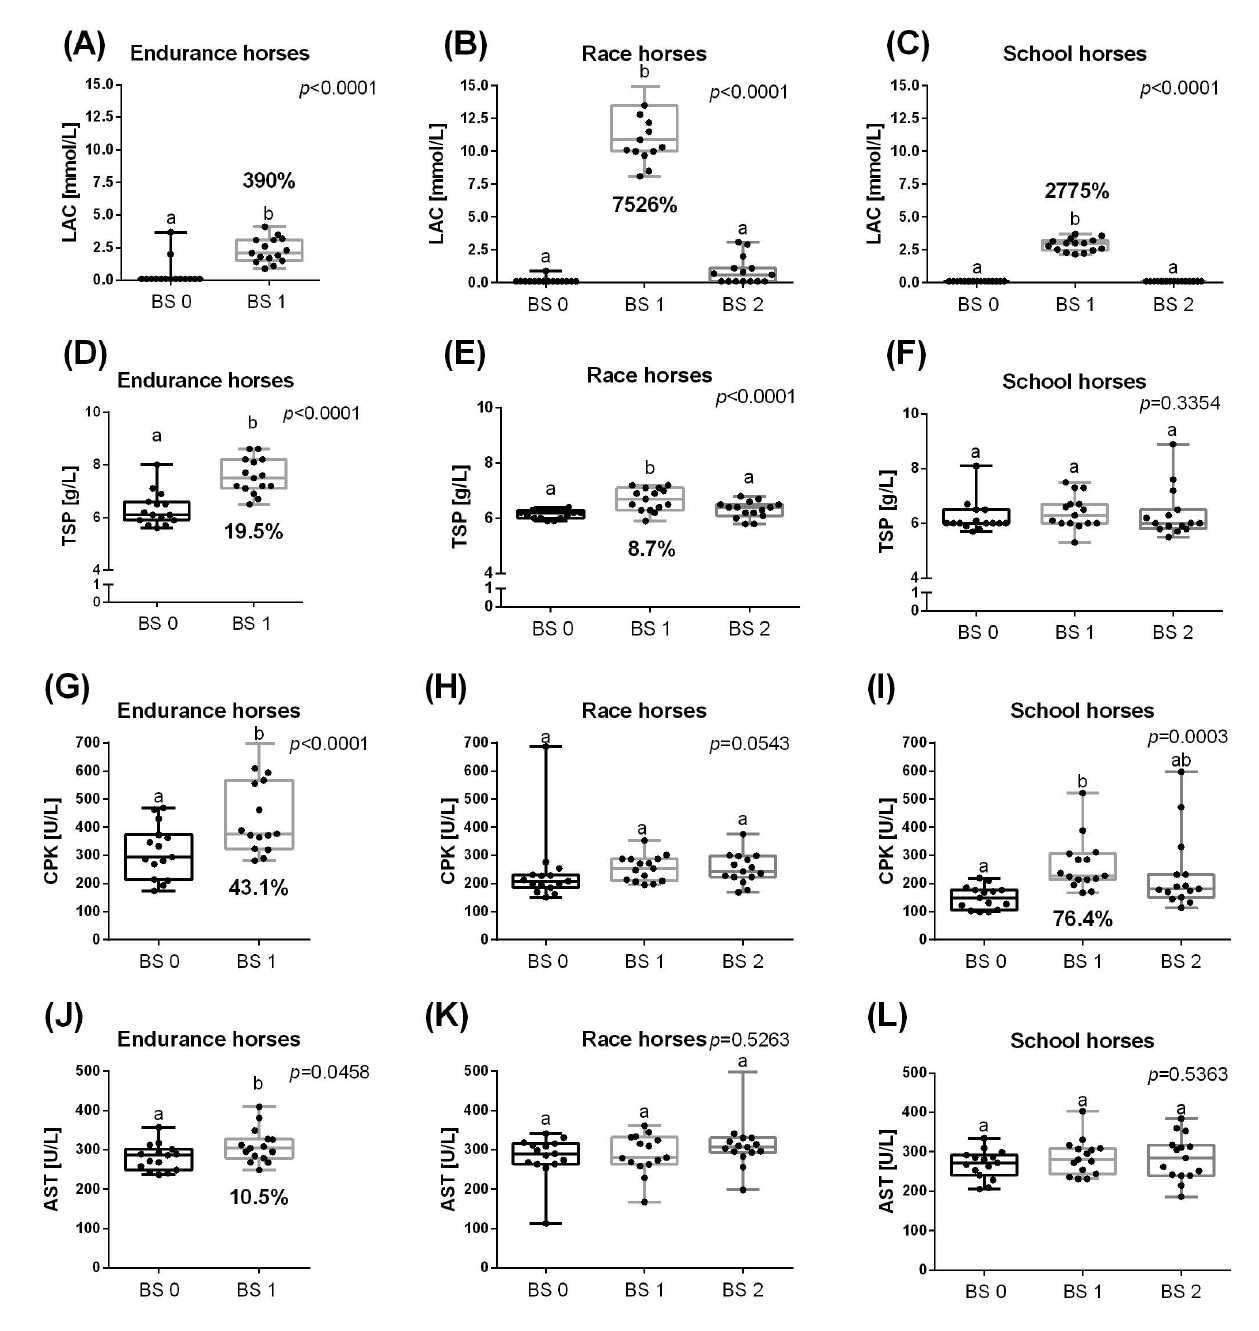
Figure 3. Selected biochemical parameters (mean + SD), lactate concentration (LAC) ( A – C ); total serum protein (TSP) ( D – F ); creatine phosphokinase (CPK) ( G – I ); aspartate aminotransferase (AST) ( J – L ), measured before training (BS 0; individual values marked with dots), immediately after training (BS 1; individual values marked with squares) and 30 min after training (BS 2; individual values marked with triangles) in endurance horses ( A , D , G , J ), race horses ( B , E , H , K ) and school horses ( C , F , I , L ). Lower case letters indicate differences between BSs for p <